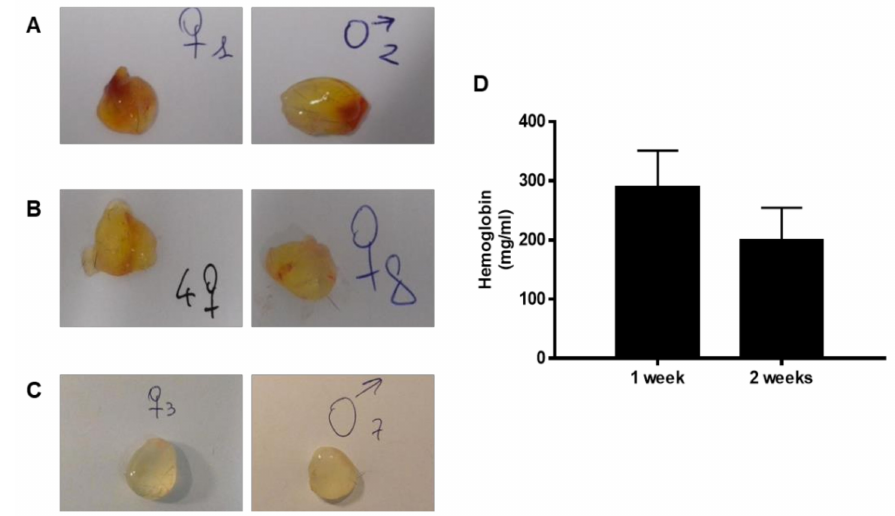
Figure 6. Representative images of the subcutaneous Bioexpander ® plugs recovered at di ff erent times. The pictures in A, B, and C report samples of the isolated subcutaneous implants. After one week (panels A ), implants were clearly vascularized, while at two weeks vascularization was absent or partial, being present in some small spots (panels B ). The content of haemoglobin (panel D ) confirms reduction of vascularization. After four weeks (panels C ), no implant was vascularized. For each time, two images are reported as representative of at least seven of the implants